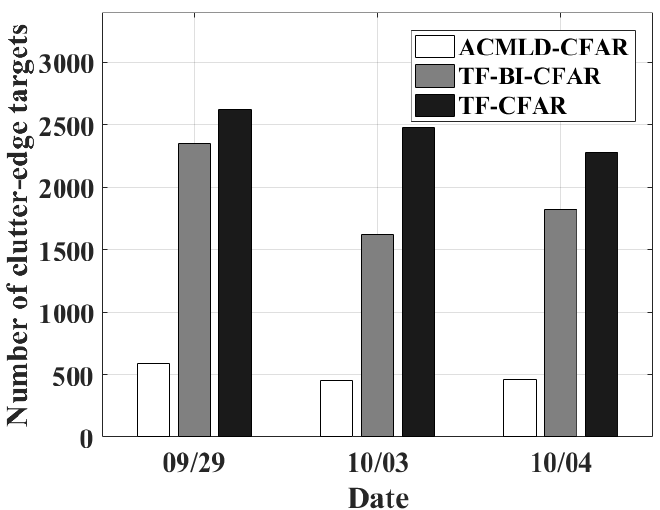
Figure 13. The number of matched targets at the edge of Bragg peaks on different dates. Table 5. Comparison of matched targets by TF-CFAR and other six CFAR detectors at the edge of Bragg peaks.